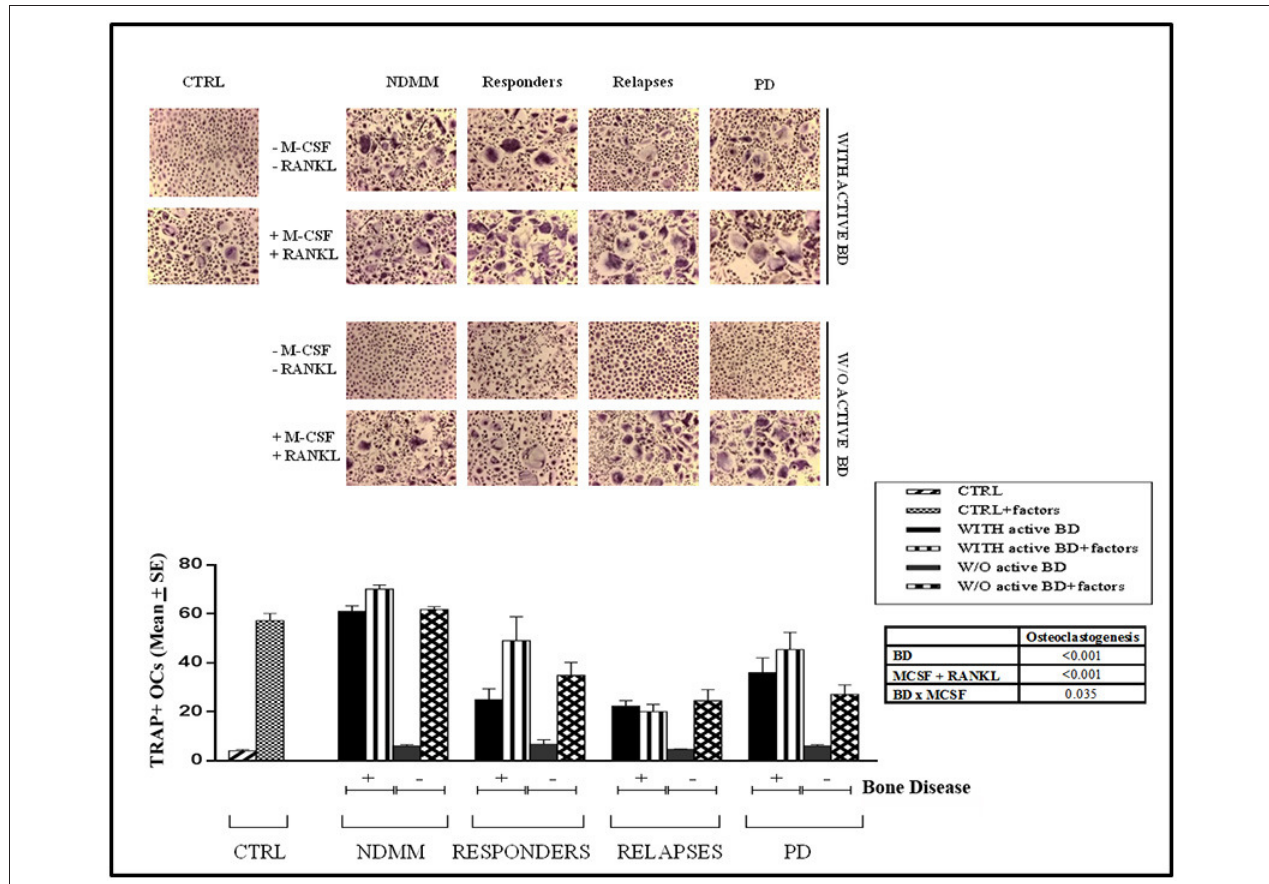
FIGURE 4 | Spontaneous osteoclastogenesis in MM patients with active bone disease experiencing the therapeutic regimens. OCs were obtained from unfractionated PBMCs of controls (CTRL) and newly diagnosed multiple myeloma (NDMM) patients with or without active bone disease (BD), responders, at relapse and progressive disease (PD). Numerous, large OCs developed in the unstimulated cultures (-MCSF/RANKL) from all the MM patients with active BD, whereas rare, and small OCs were observed in the cultures from all the MM patients without active BD and CTRLs. No significant increase in OC formation was observed in PBMCs of NDMM patients with BD, at Relapse and PD due to exogenous M-CSF and RANKL (factors), whereas these cytokines significantly affected osteoclastogenesis in responder patients with active BD as well as all MM patients without BD and the CTRL. Multinucleated ( > 3 nuclei per cell) and TRAP + cells were identified as OCs (magnification, × 200). The histograms represent the mean values ± S.E. obtained from all the enrolled controls and patients. Results reported in the table are for two-way ANOVA on treated and untreated cultures for controls and